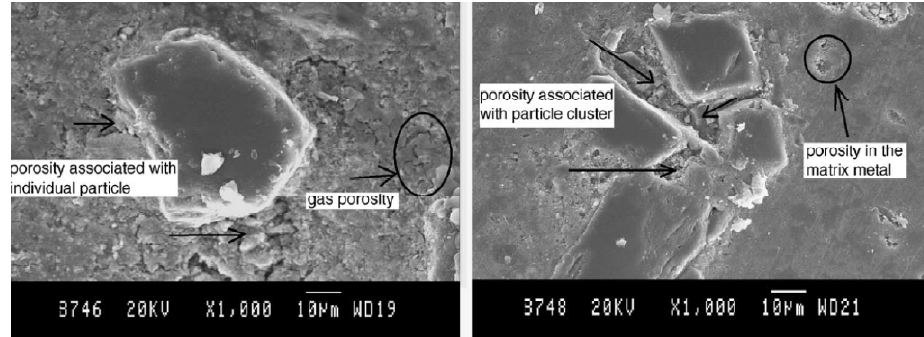
Fig. 4. SEM micro graphs of a typical porosity cluster in MMC. Reprinted with permission